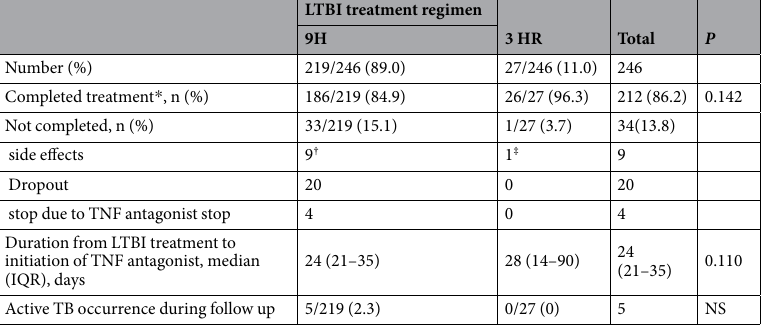
Table 2. Treatment regimens and outcomes for LTBI in 246 patients. Data are presented as numbers (percentages) unless otherwise indicated. * Completed Treatment was defined as the ingestion of > 80% of all prescribed medications within 43 weeks for 9H or within 16 weeks for 3HR. † Five hepatitis, two active TB during LTBI treatment, one skin rash and one mood change. ‡ One skin rash. LTBI, latent tuberculosis infection; H, isoniazid; HR, isoniazid plus rifampicin; TNF, tumor necrosis factor; TB, tuberculosis; NS, not